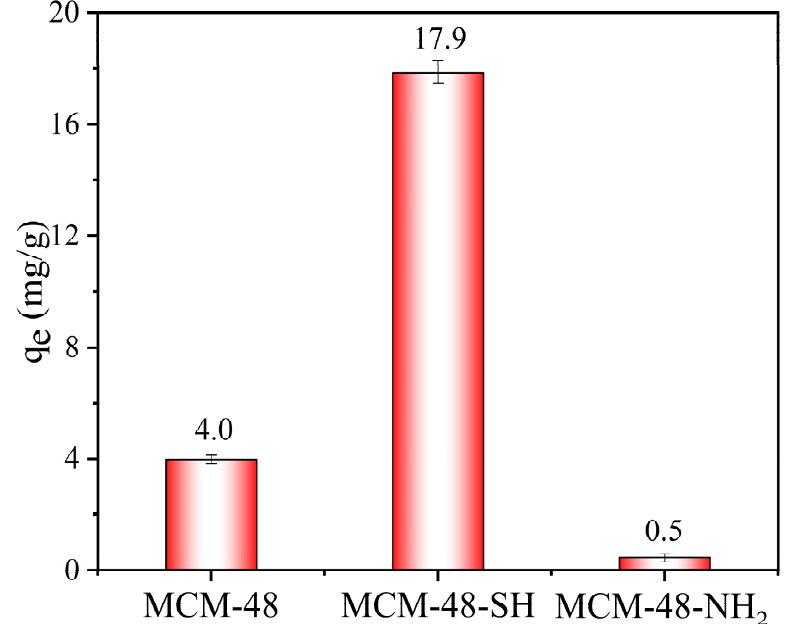
Figure 6. Comparison of the adsorptions of Cr(VI) by MCM-48, MCM-48-SH, and MCM-48-NH 2 (the reaction temperature was 25 °C, the amount of adsorbent was 100 mg, the pH of the solution was 2, and the reaction time was 3 d).